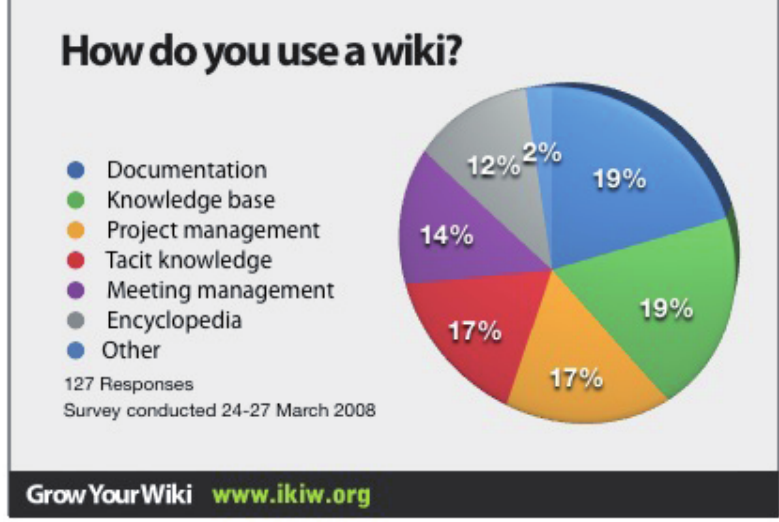
Figure 2: Different uses of